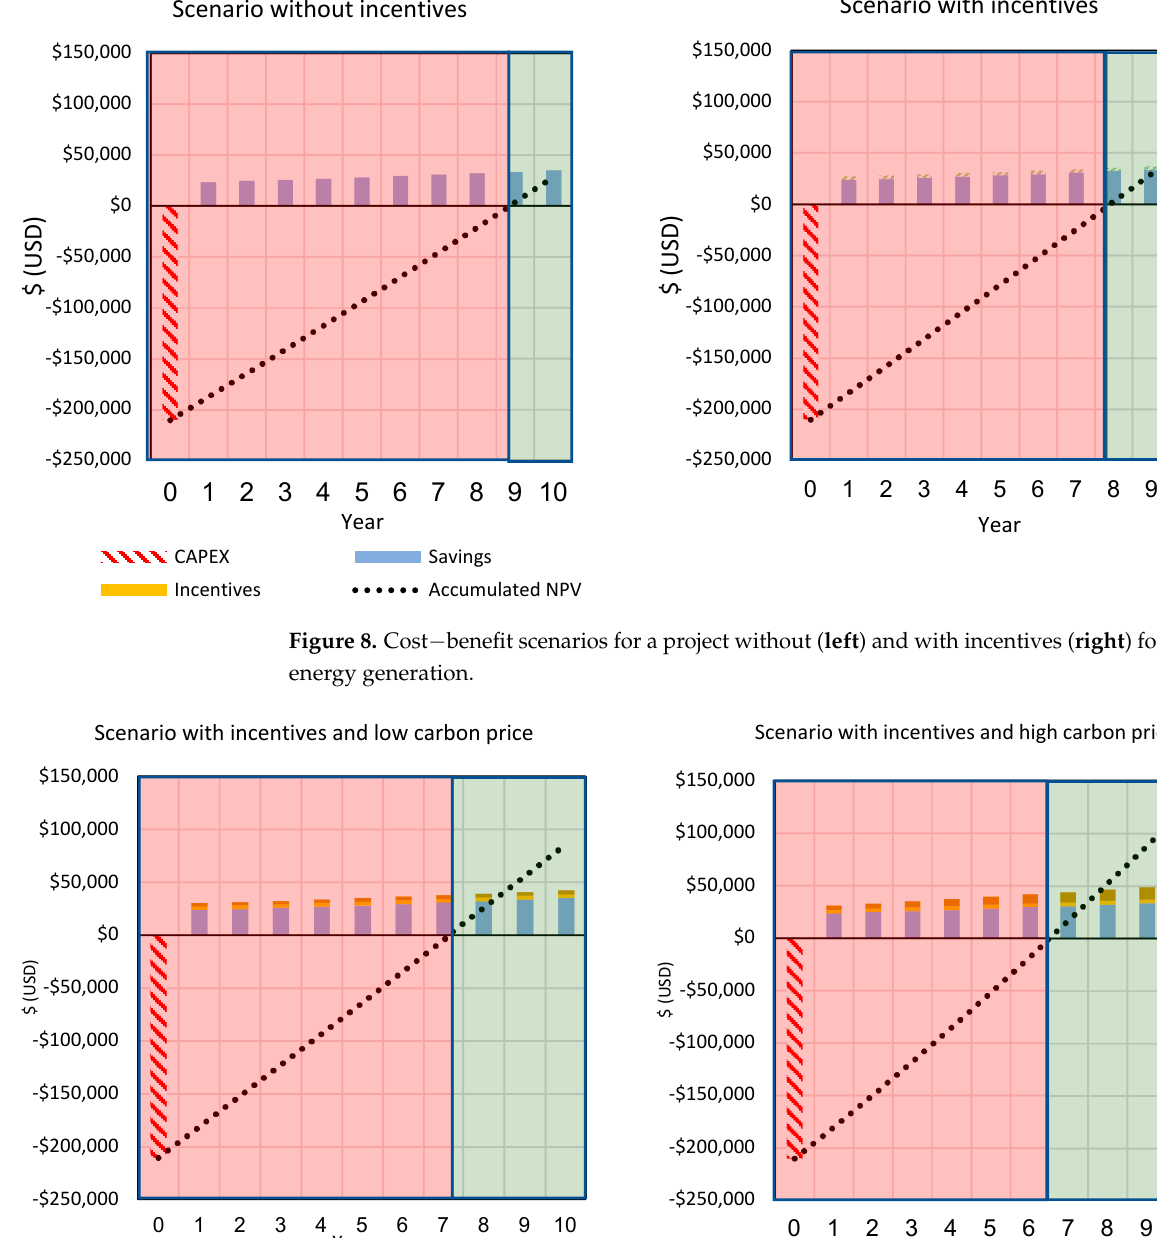
Figure 9. Cost − benefit scenarios for a project with incentives and an additional carbon incentive for low price scenario ( left ) and high − price scenario ( right ).